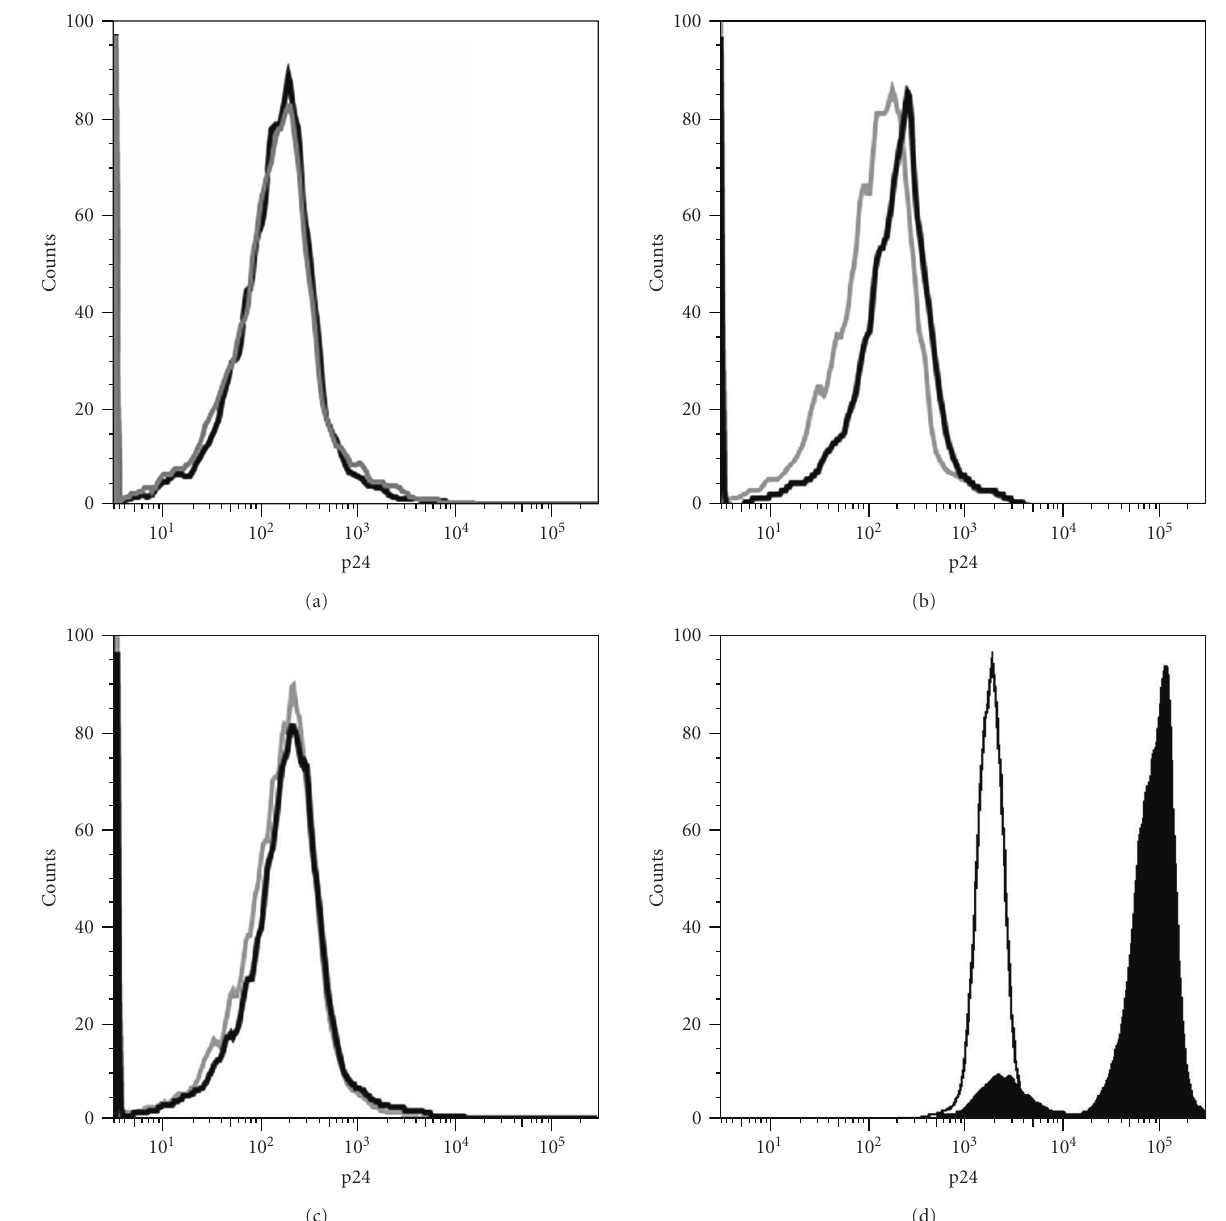
Figure 3: CD8 + T having acquired CD4 bind HIV particles. (a) Expression of p24 on CD8 + T cells having captured (open black histogram) or not (closed grey histogram) CD4 in a previous coculture (as shown in Figure 2 but target cells are HEK-FcR stably transfected with human CD4) and incubated with uninfected MOLT-4 cells. Shown are overlaps of p24 staining on gated CD8 + T cells. (b) As in (a) except that infected MOLT-4 cells were used in the coculture with CD8 + T cells. (c) As in (b) except that the Leu3a neutralizing anti-CD4 mAb was present during the coculture. (d) Shown are overlap of p24 staining on uninfected MOLT-4 cells (as in condition shown in (a), open black histograms) and on infected MOLT-4 cells (as in conditions shown in (b) and (c), closed black histograms). Note that MOLT-4 cells were analyzed from the coculture with T cells and with the very same settings used for the analysis of T cells, which explains the high autofluorescence of MOLT-4 cells, which is related to their larger size. Similar results were obtained in a second independent